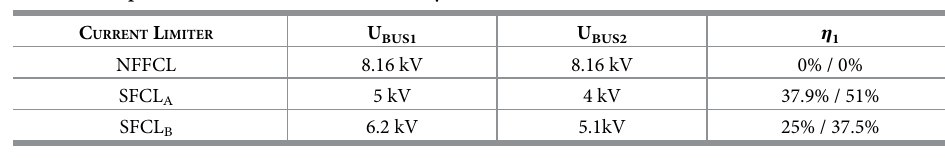
Table 3. Comparison of 3LG FRT transient